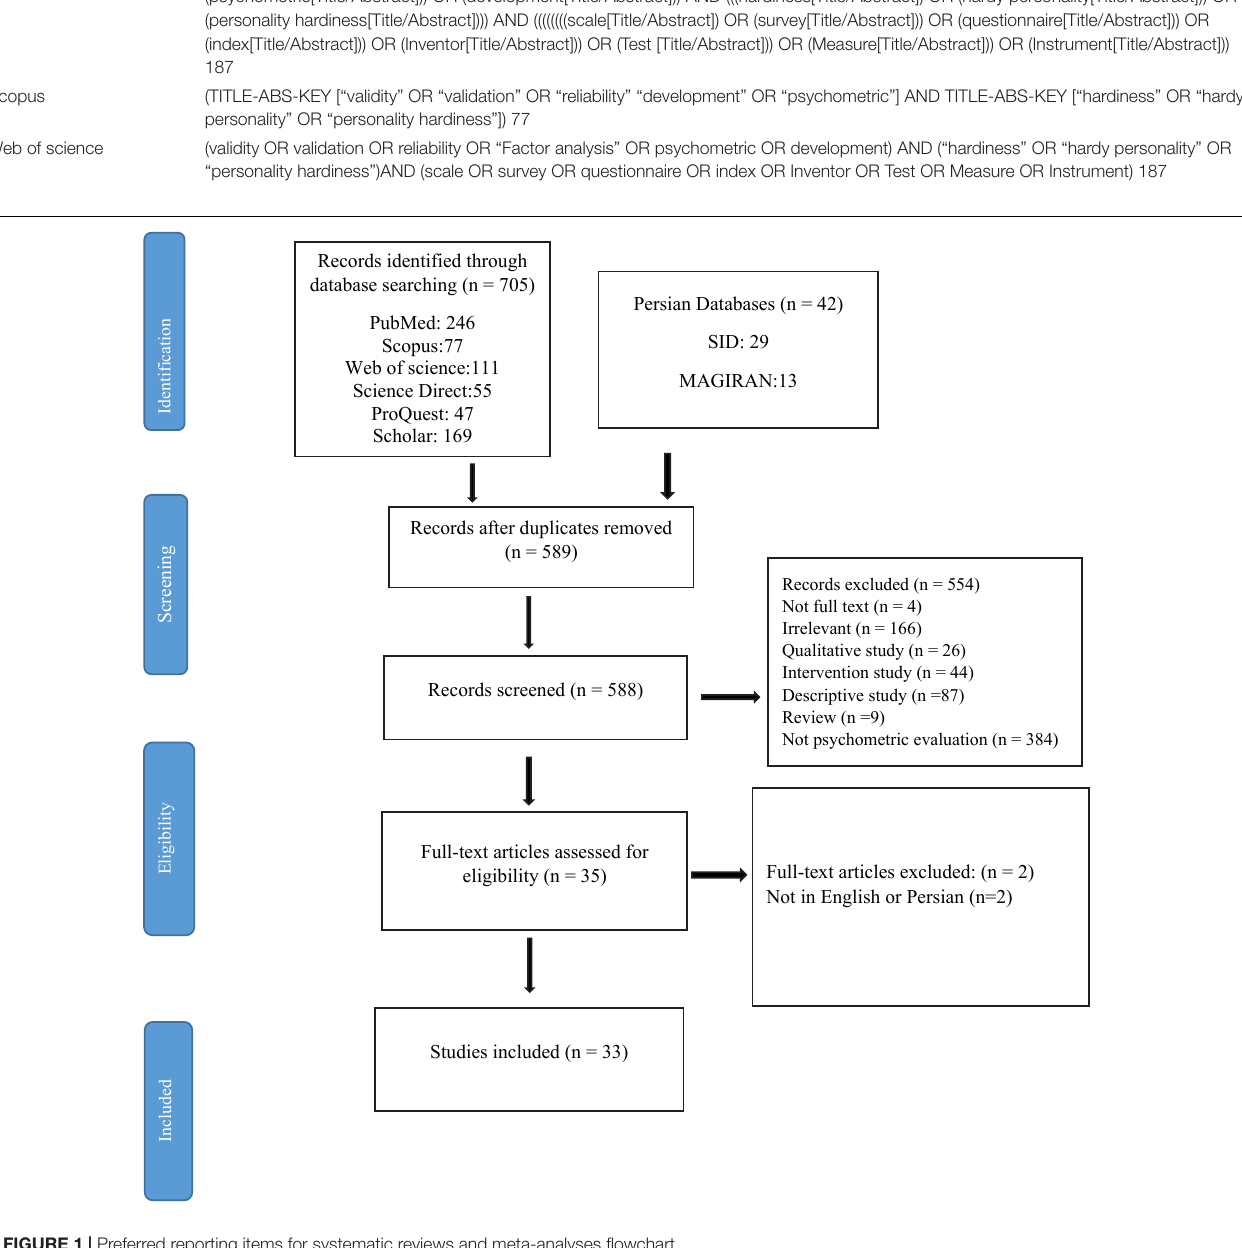
TABLE 1 | Keywords used in the search for the different databases. Databases Search string PubMed